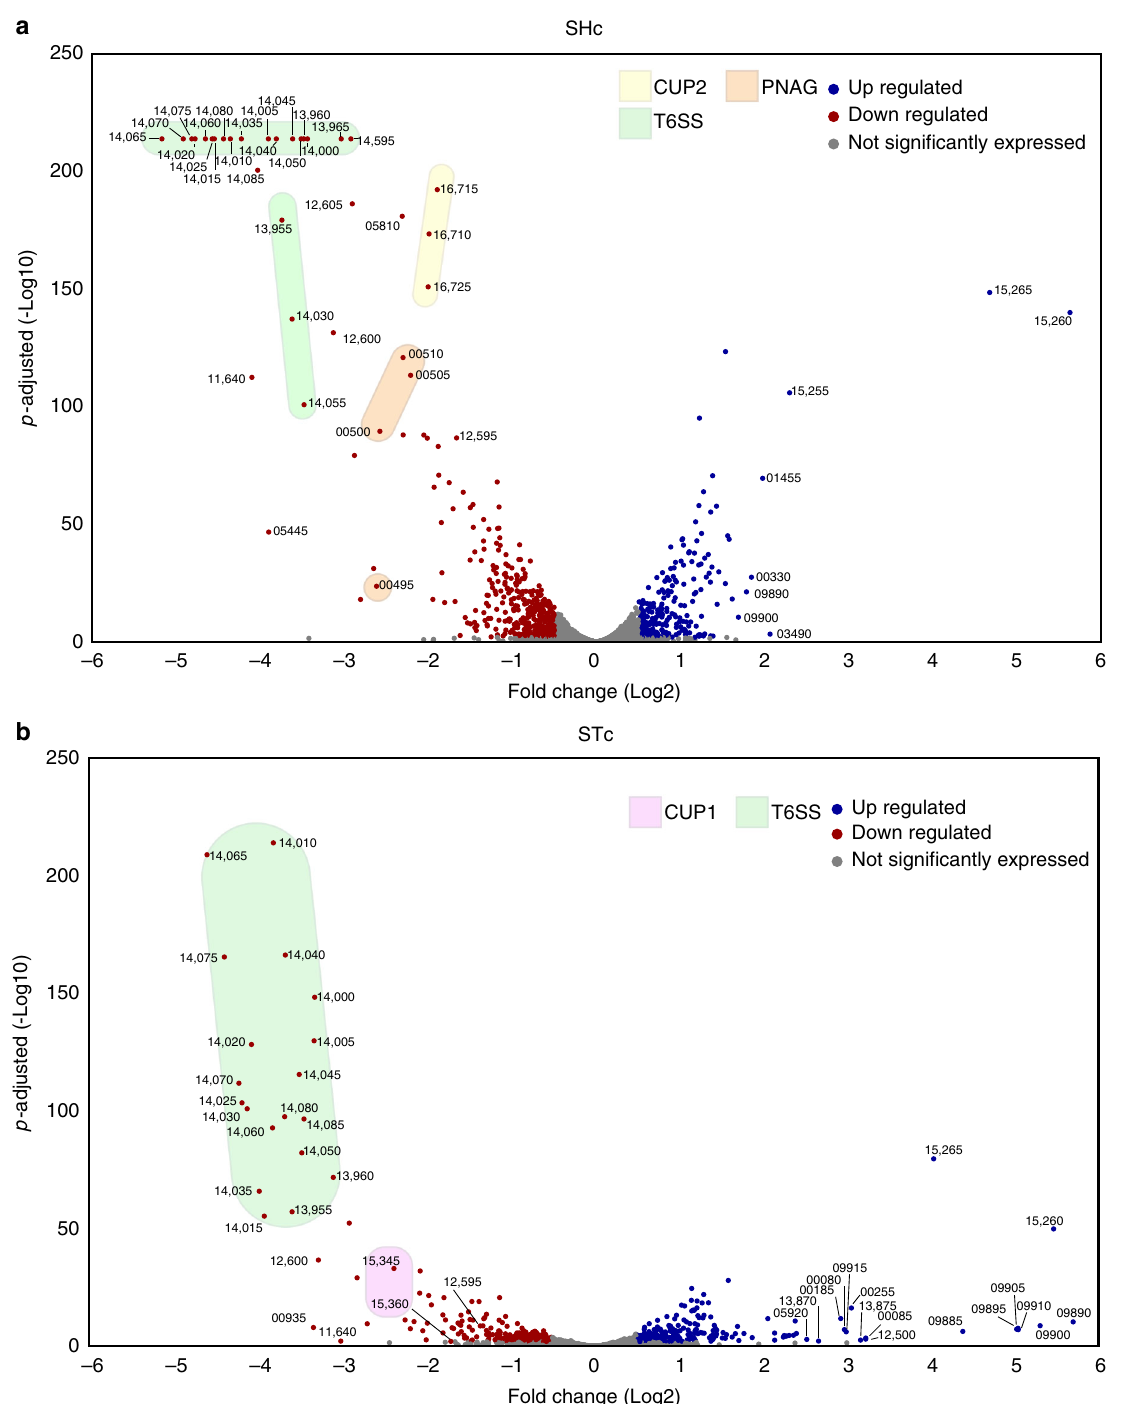
Fig. 7 pAB5 differentially modi fi es the expression of chromosomal genes. DEGs with adjusted p -value < 0.1 for shaking ( a ) and static ( b ) grown conditions are depicted as a volcano plot to show the relationship between Log2 fold change and statistical signi fi cance. Each circle depicts one gene, upregulated genes are blue and downregulated genes are red, with the accession number shown for select genes. Pink shadow highlights the genes encoding for CUP1 pili, yellow shadow highlights the genes encoding for CUP2 pili, orange shadow highlights the genes of PNAG biosynthetic pathway and green shadow highlights the genes encoding for the T6SS. Three biological replicates of each condition were analyzed. All genes in the transcriptomic volcano plot with adjusted p -values above the statistical cut off of 0.1 (i.e., not signi fi cantly different between conditions) per the DESeq2 vignette are in gray, while the genes with adjusted p -values below 0.1 are blue or